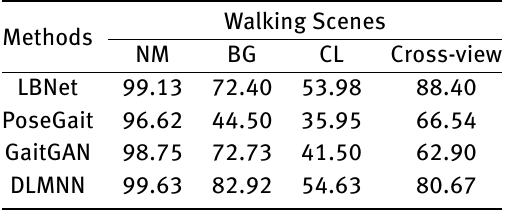
Table 5: Comparison with the state-of-the-art. The Average recognition rates (%) at different walking